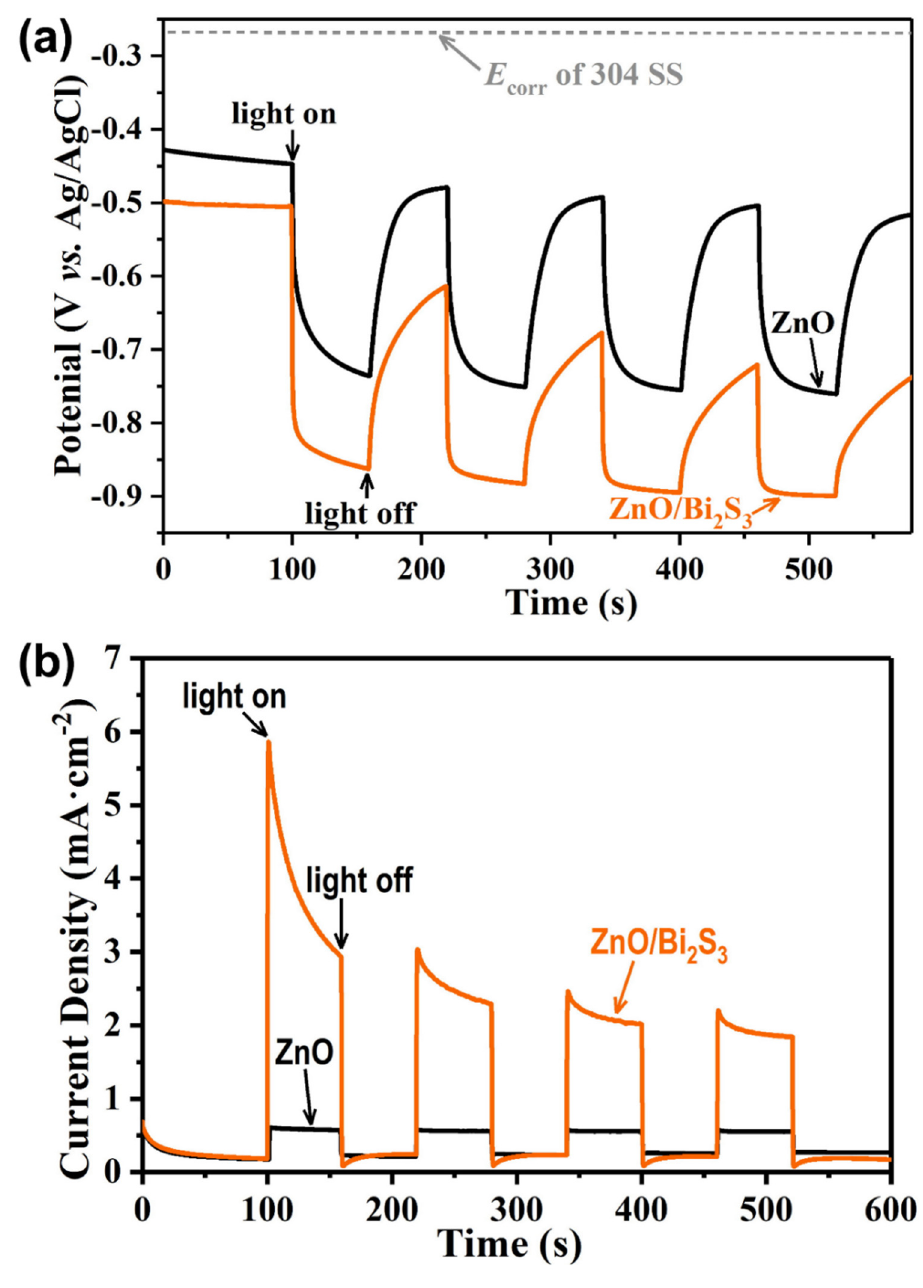
Figure 6. ( a ) Time evolution of photogenerated OCP for 304 SS coupled with ZnO or ZnO/Bi 2 S 3 photoanodes under intermittent illumination. ( b ) Transient photocurrent responses of ZnO and ZnO/Bi 2 S 3 photoanodes.